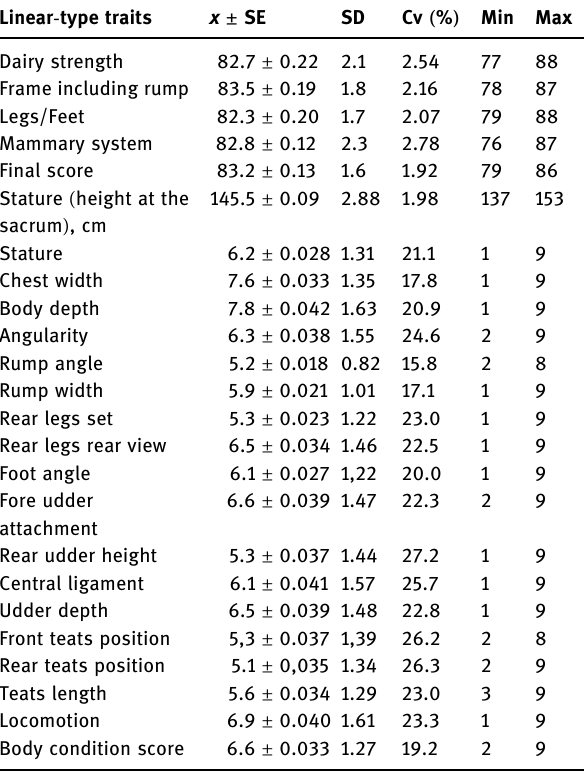
Table 2: The average value and variability of linear - type traits of fi rst - born cows of the Ukrainian Brown dairy breed Linear - type